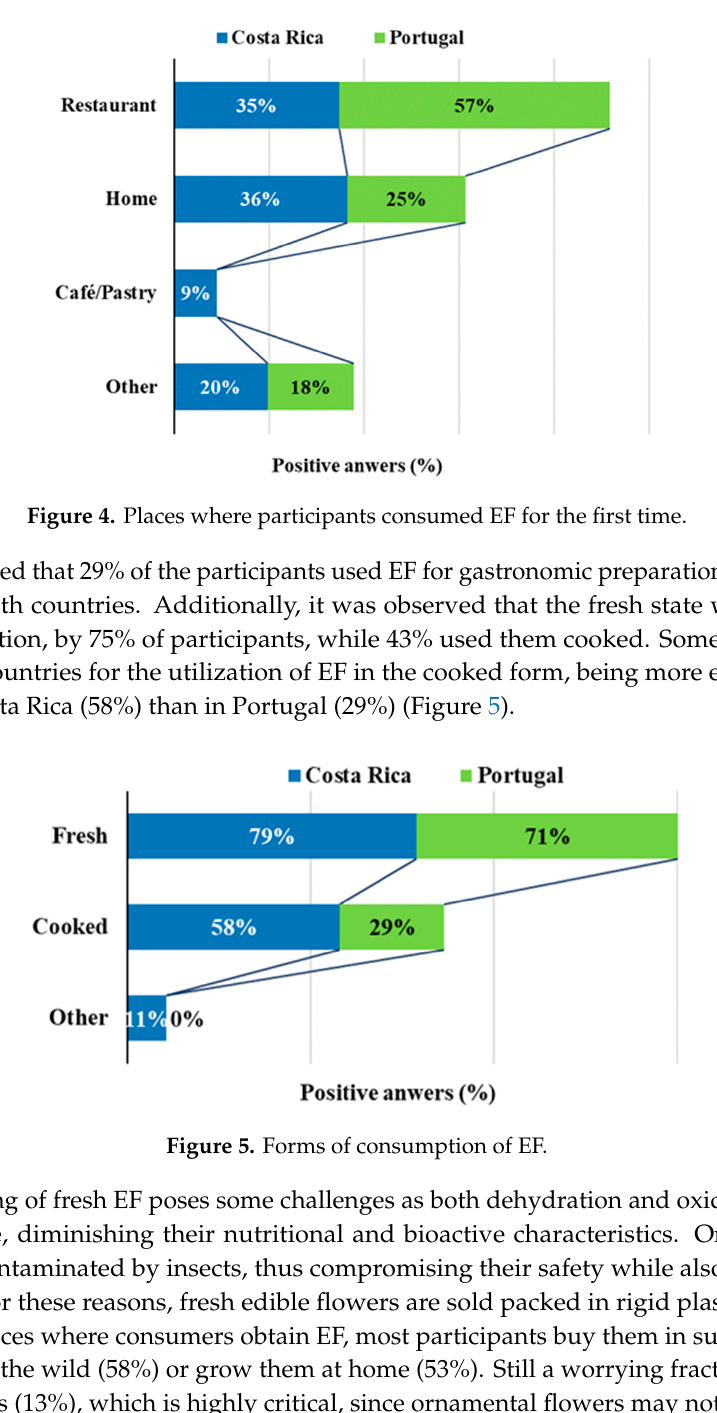
Figure 3. Reasons pointed out by the participants for consumption of EF.